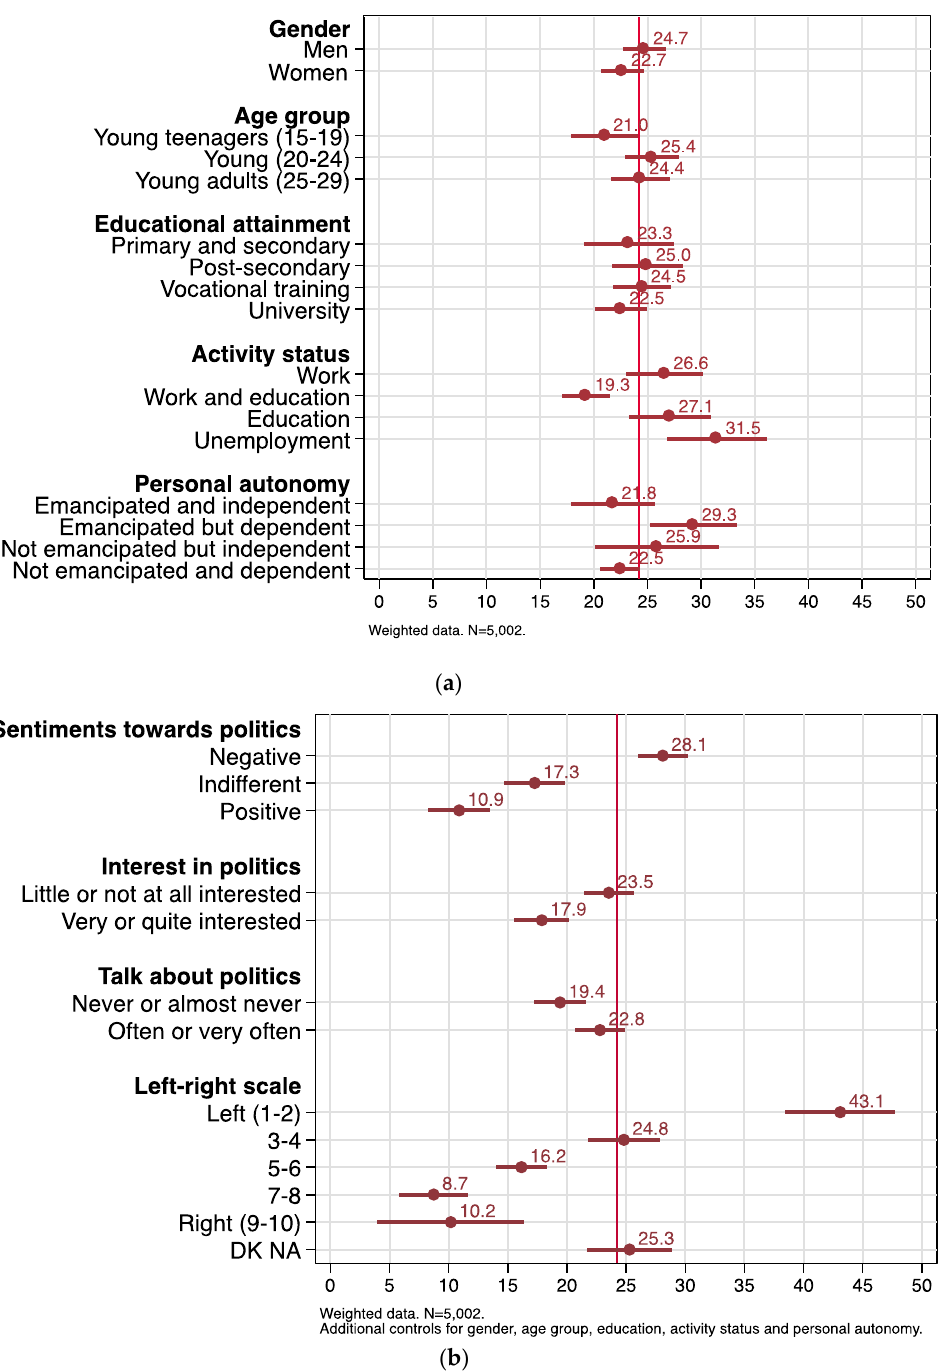
Figure 9. Predicted probabilities of political discontent. ( a ) Socioeconomic predictors; ( b ) political predictors. Variable “political discontent” contains information about dissatisfaction with the way in which democracy works in the country as well as mistrust in politicians and political parties. See details on the construction of the variable and the formulation of the questions in the text. Weighted data. Source: Young People in Spain Survey, 2016.